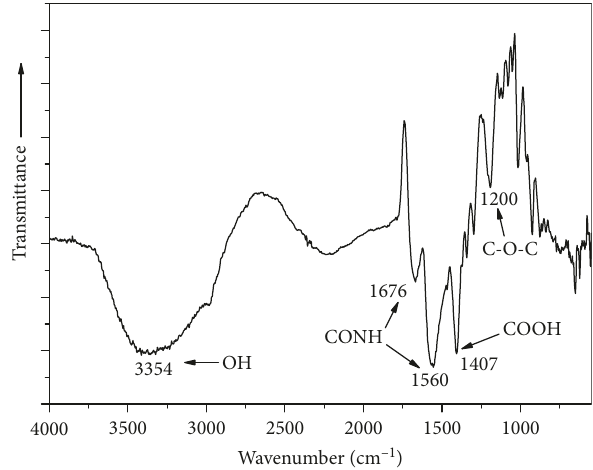
Figure 2: FTIR spectra of Grewia spp. biopolymer. Table 1: Molecular mass of Grewia spp. biopolymer.